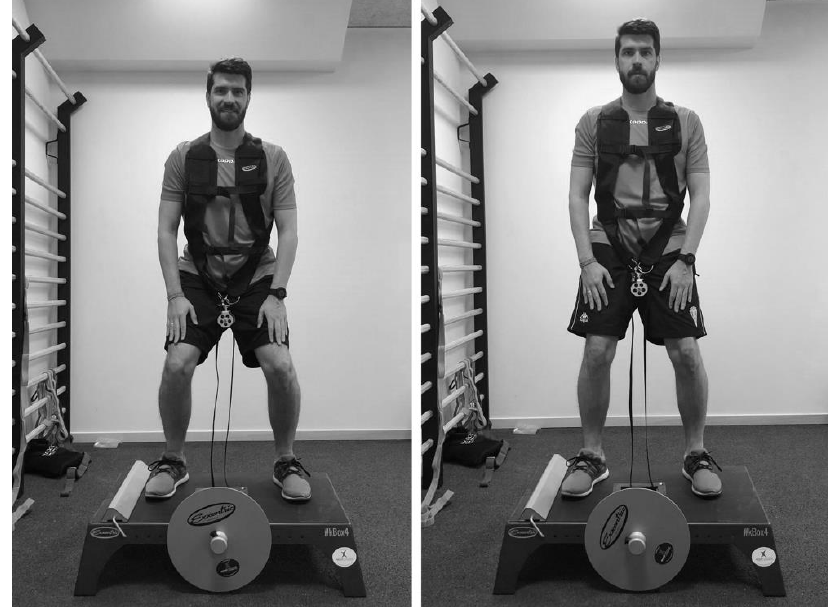
Figure 1. Half-squat exercise performed in the study.